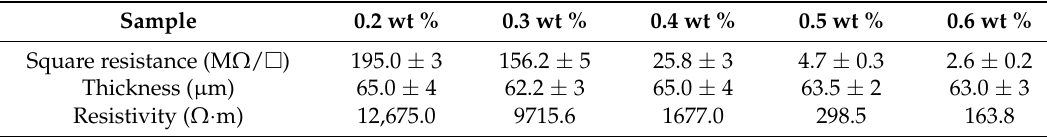
Table 1. Resistivity of MWCNTs/WPU conductive coating with different MWCNT contents. Sample